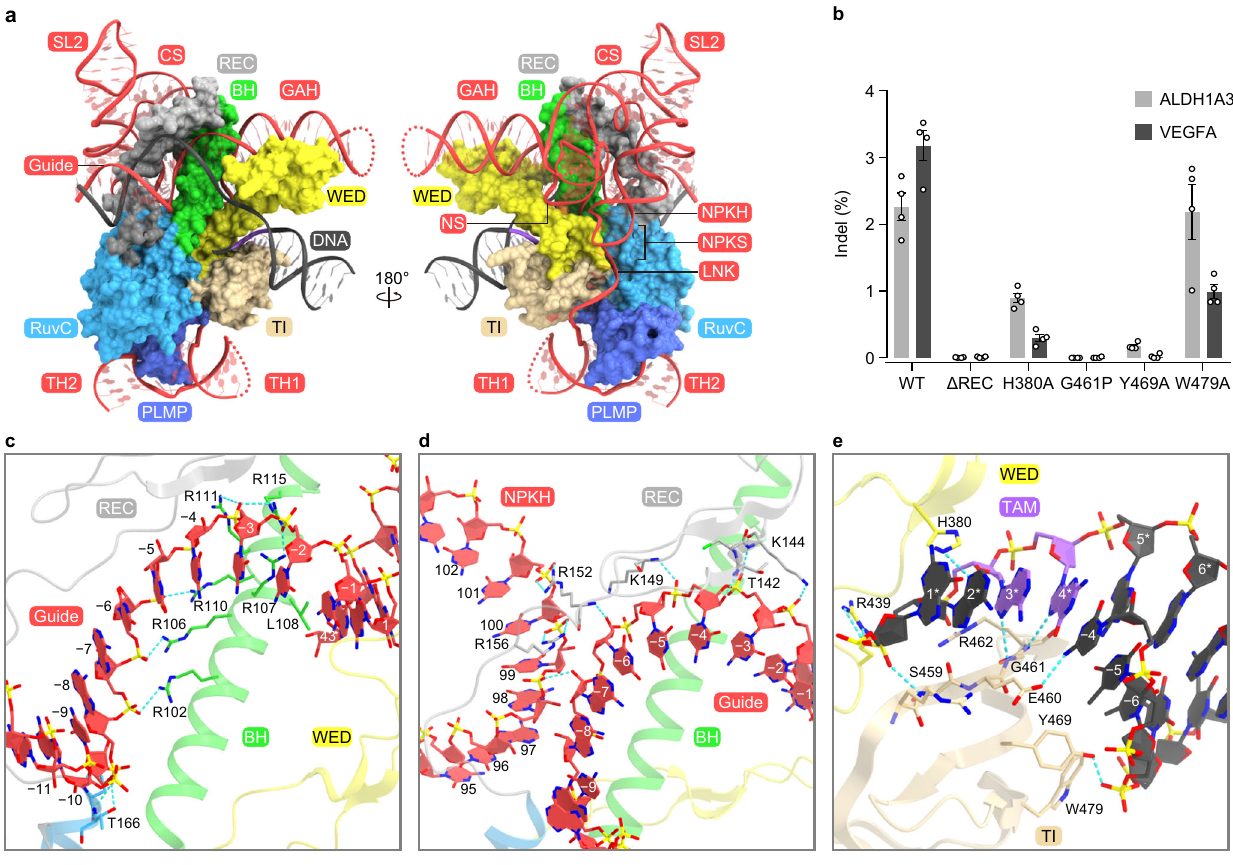
Δ REC is the REC mutant in which residues 129 – 144 were replaced with a GGGS linker. Data are mean±s.e.m. ( n =4, biologically independent samples). The experiments were repeated four times with similar results. Source data are pro- vided as a Source Data fi le. c – e Recognition of the seed region ( c , d ) and the TAM ( e ). Hydrogen bonds are shown as dashed